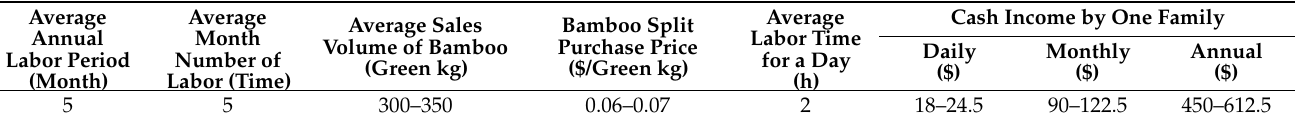
Table 3. Labor and income information on bamboo harvesting for a three-person village family.